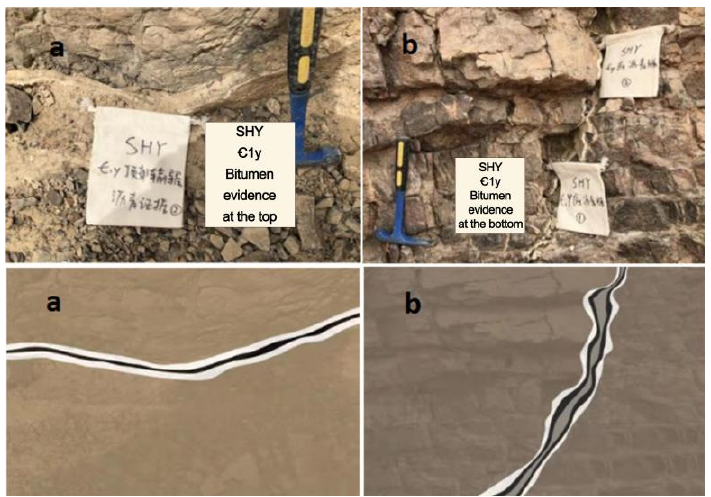
Figure 8. Single-stage bitumen vein of the Yuertus Formation in the Shihuiyao section: ( a ) top of the Yuertus Formation; ( b ) bottom of the Yuertus Formation.